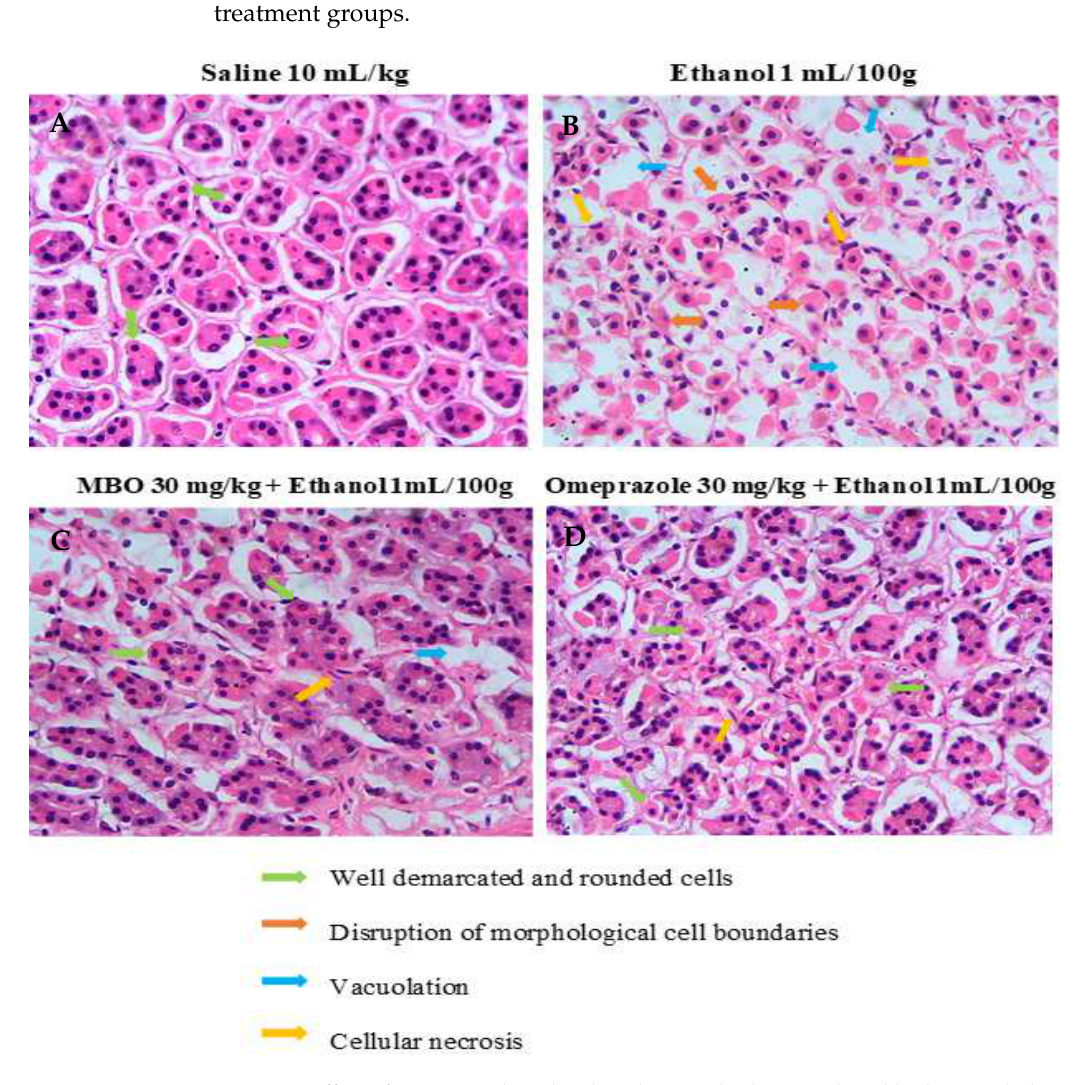
Figure 5. Effect of MBO on ethanol-induced stomach ulcers analyzed by histopathological technique. Gastric tissues ( n = 5) from each experimental group were processed for histological changes after 1 h of ethanol treatment. Magnification 40×. ( A ) Saline 10 mL/kg; ( B ) ethanol 1 mL/100g; ( C ) MBO 30 mg/kg + ethanol 1 mL/100g; ( D ) omeprazole 30 mg/kg + Ethanol 1 mL/100g. Green, orange, blue, and yellow arrows represent well-demarcated and rounded cells, disruption of morphological cell boundaries, vacoulation and cellular necrosis, respectively.